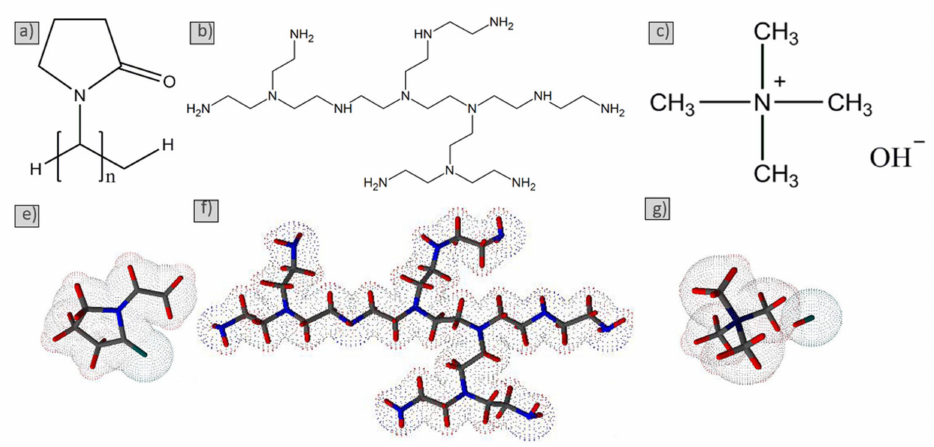
Figure 1. Chemical and partial spatial formula of polyvinylpyrrolidone (PVP) ( a , e ), polyethyleneimine (PEI) ( b , f ), and tetramethylammonium hydroxide (TMAH) ( c , g